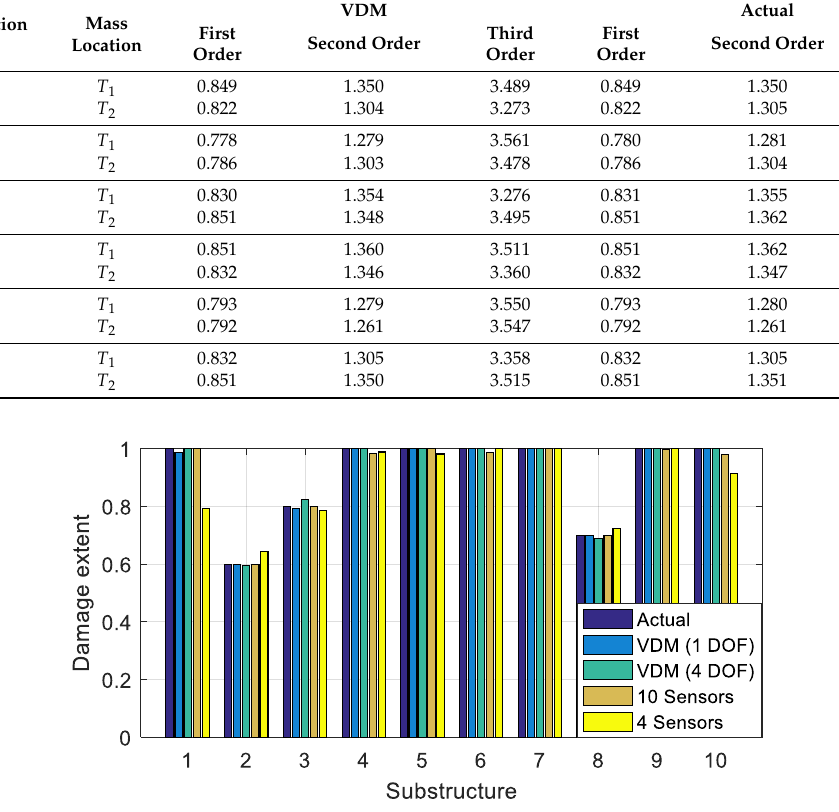
Table 5. First four natural frequencies (Hz).